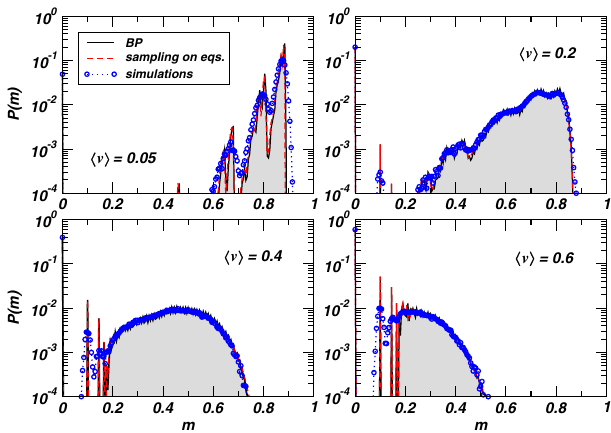
FIG. 7. Distribution P ð m Þ of the probability m that a node got infected during the SIR process on random regular graphs of degree K ¼ 4 for h v i ¼ 0 . 05 , 0.2, 0.4, 0.6. Results are computed using BP by means of Eq. (17) (black solid line) on infinite networks, by sampling solutions of Eqs. (5a) and (5b) (red dashed lines) and by means of simulations of the stochastic dynamics, both on a finite network of N ¼ 10 3 nodes and with a sample of 10 4 immunization